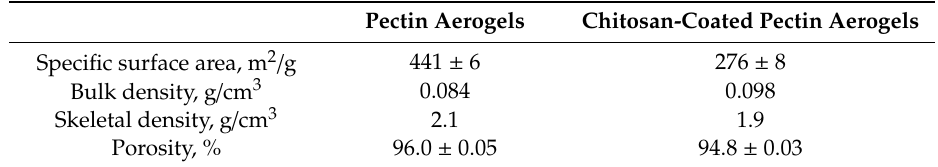
Table 1. Specific surface areas, densities and porosities of pectin aerogels and chitosan-coated pectin aerogels.